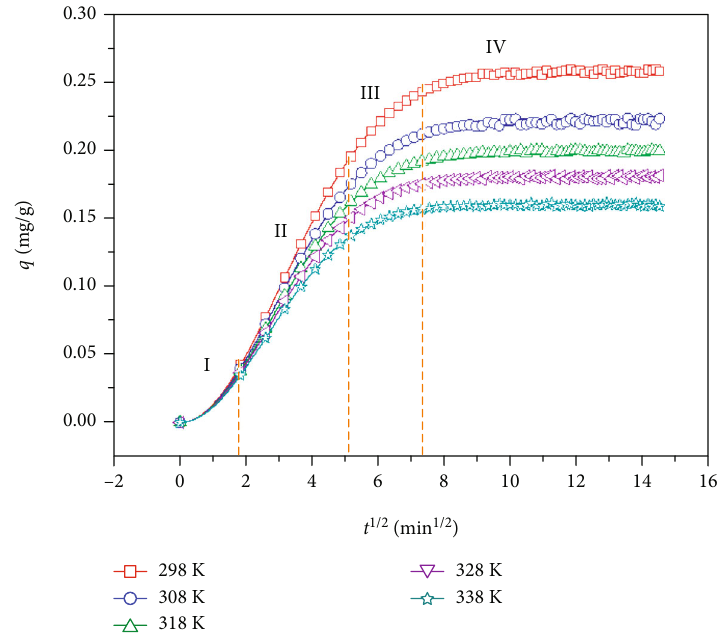
Figure 18: Prediction of intraparticle di ff usion model for HF adsorption on